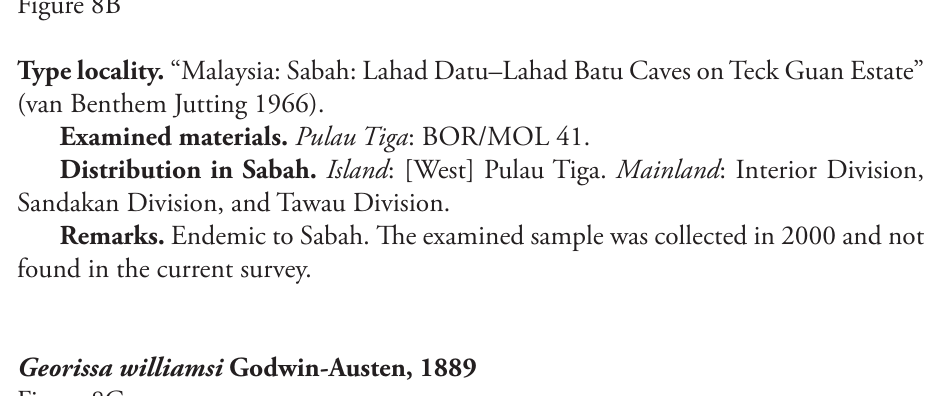
Type locality. “Borneo” (Godwin-Austen